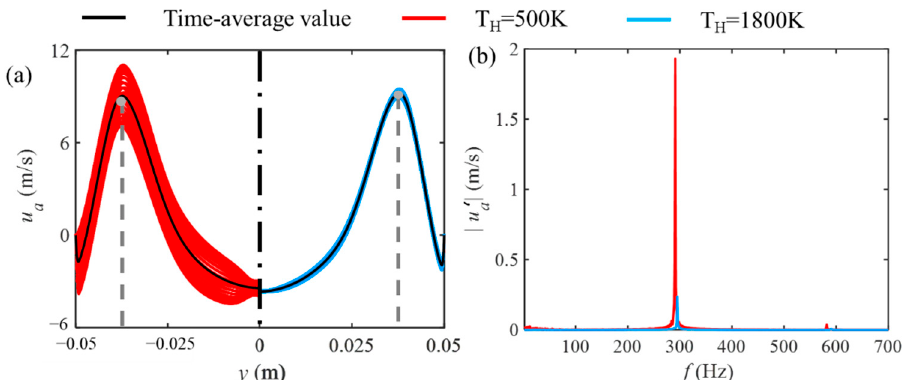
Figure 16. ( a ) Radical variation of instantaneous over an oscillation period at the x/R c = 1.2 cross section for T H = 500 K ( left ) and T H = 1800 K ( right ). ( b ) Corresponding axial velocity frequency spectrum at the maximum axial velocity value point, where S N = 0.45, V a = 180 L/min and T i = 300